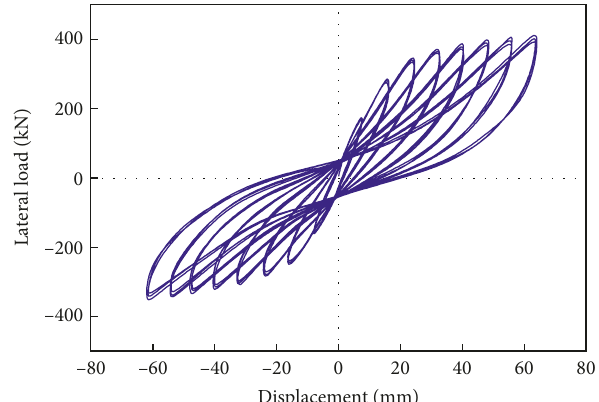
Figure 11: Lateral load vs. top displacement curve.